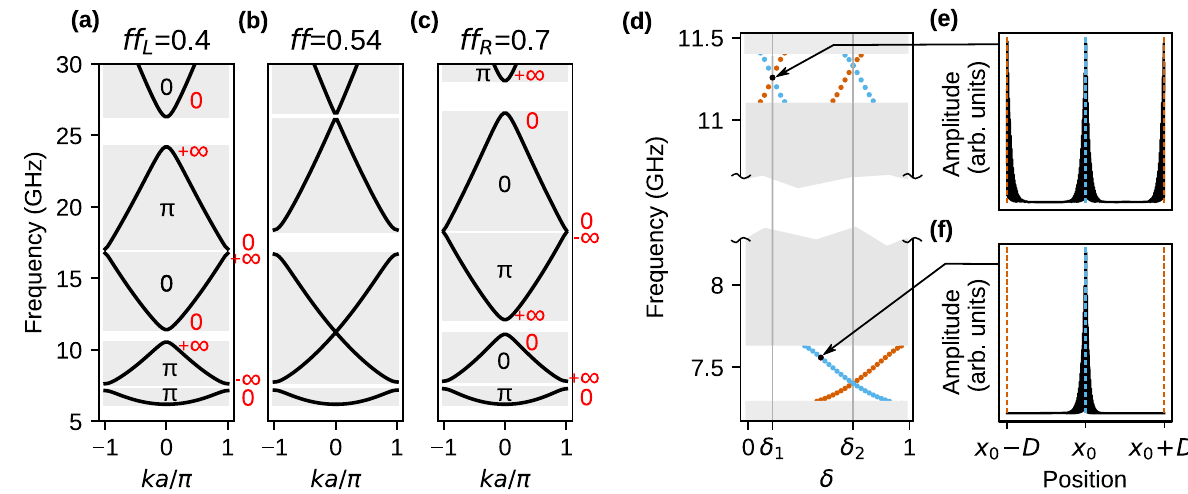
Figure 3. ( a – c ) Closing and reopening of the frequency gap (above the 2nd band, in the center of 1 st Brillouin 0 ) with the changes of filling fraction ff for exchange waves. The successive dispersion relations zone: k = 0.4 , ( b ) just closed, ff 0.54 , and ( c ) opened again, ff R 0.7 . were plotted when the gap is ( a ) opened, ff L = = = The labels: 0 and π stand for the Zak phases of the bands, 0 and (red color) - for logarithmic derivative on ∞ the edges of band gaps. The values of Zak phases and logarithmic derivatives were determined for the case δ δ 1 (i.e., for Co strip in the center of the unit cell). The SW interface modes localized on the interface of two = 0.4 and ff R 0.7 . ( d ) The spectrum in the function of the surface parameter δ , defining the 1D MCs of ff L = = selection of the unit cells for 1D MC on the right. The values δ 1 and δ 2 correspond to the centrosymmetric unit cell with Co and Py strip in the middle. The calculations were performed for supercell approximation, where 100 unit cells. Na and composed of N we considered the final sections of the 1D MCs, each of the size D = = Due to the application of periodic boundary conditions, we obtain an additional interface between 1D MCs. x 0 (on edge x x 0 D ) of a supercell is marked The frequency of interface mode localized in the center x = = ± by a blue dotted (orange dotted) line. ( e , f ) The profiles of the SW interface modes in the gaps above 1st and 2nd bands. The frequency and δ positions, for which modes are calculated, are indicated by arrows. The interfaces x x 0 and x x 0 D are pointed by blue dashed and orange dashed lines, respectivelly. For centrosymmetric = = ± case, the mode occupy both interface (e), while for non-centrosymmetric only one ( f